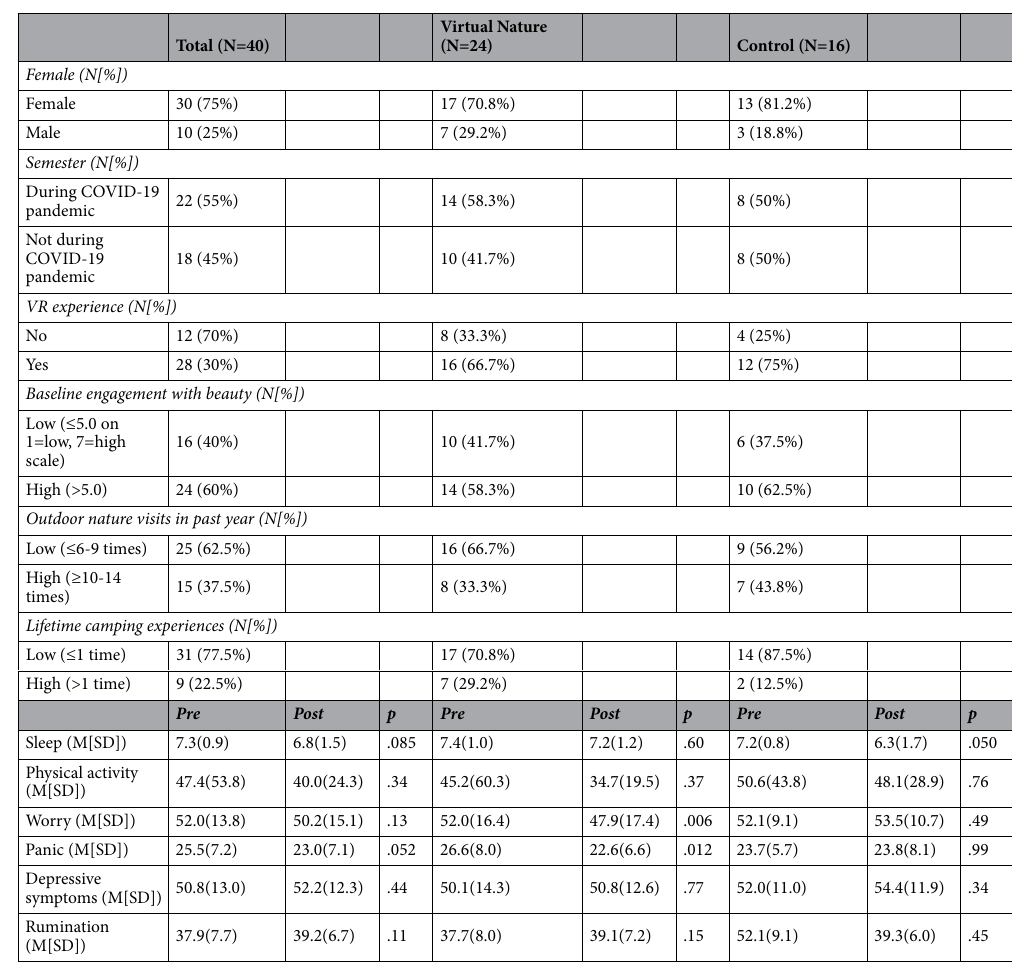
Table 1. Sample characteristics. Differences in outcome average pre/post values differ from Fig. 1, which shows medians in